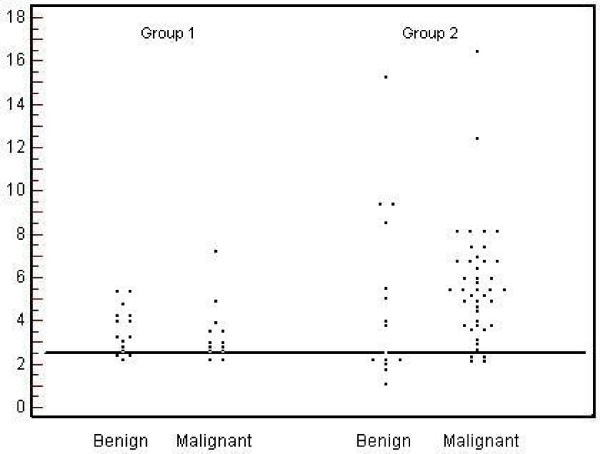
Dot diagram for groups one and two using SUVmax cut-off of 2.5.